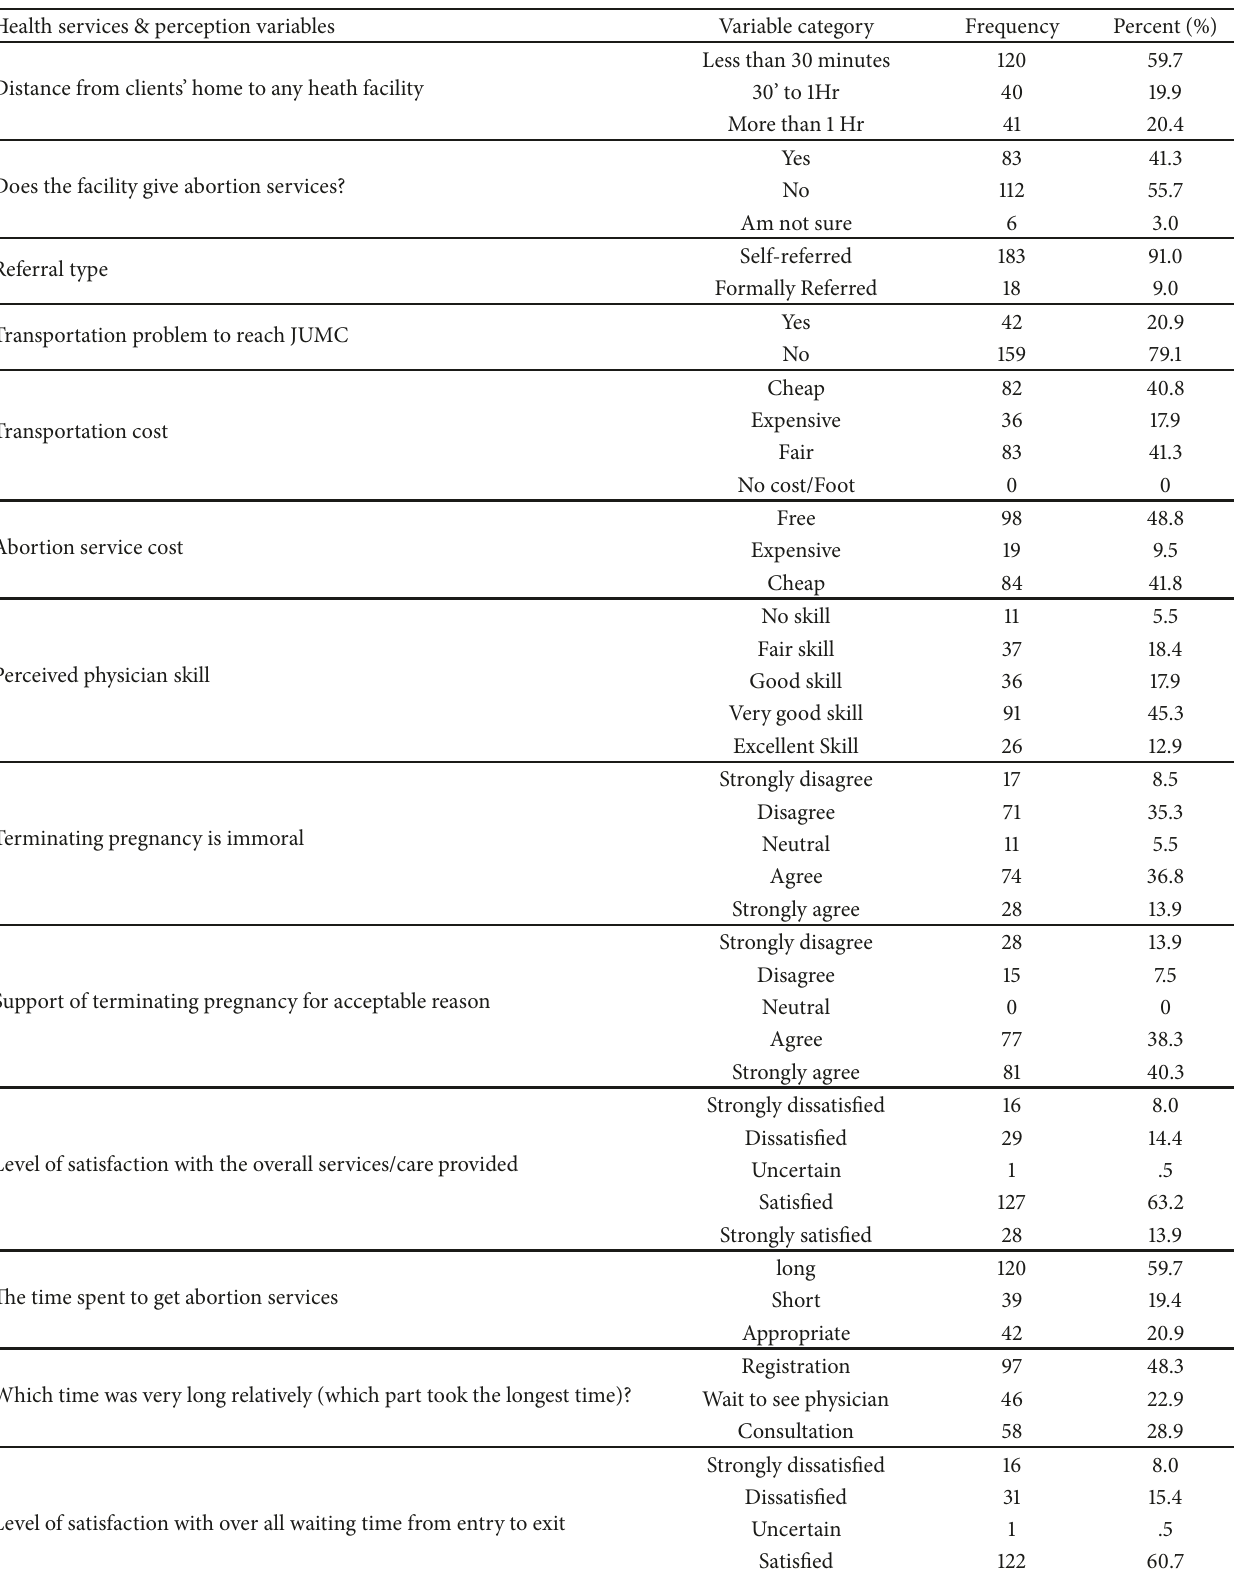
Table 4: Health services and perception related variables of women who terminated their pregnancy using safe medical abortion at the 2nd trimester in JUMC from November 1, 2016, to June 30,